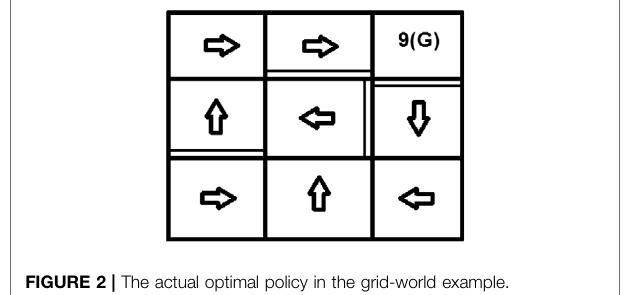
FIGURE 2 | The actual optimal policy in the grid-world example.